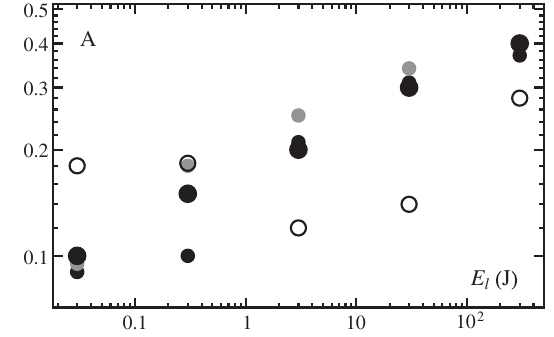
FIG. 2. The proton spectrum for optimum target thickness, l ¼ 0 . 12 λ , at time of 50 fs (dashed line), 76 fs (gray line) and 0 176 fs (solid line) for laser with E L ¼ 30 J, τ ¼ 30 fs, and d ¼ 4 μ m.